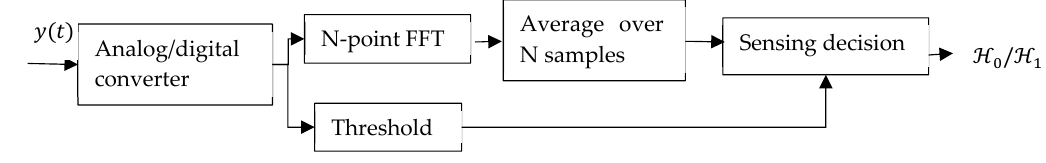
Figure 2. Block diagram of Energy Detection [5–20].